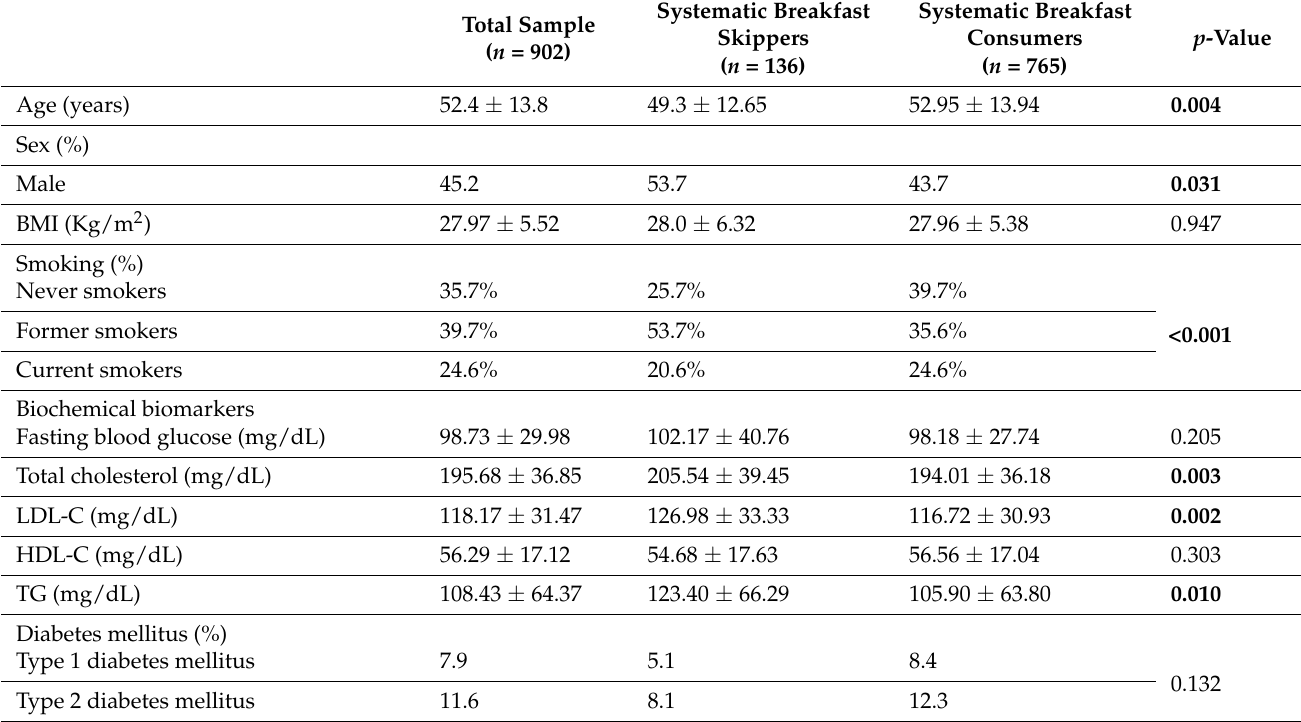
Table 1. Descriptive and clinical characteristics of the study